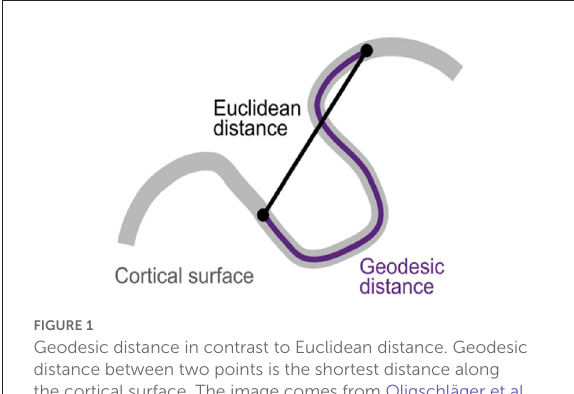
FIGURE1 Geodesic distance in contrast to Euclidean distance. Geodesic distance between two points is the shortest distance along the cortical surface. The image comes from Oligschläger et al.